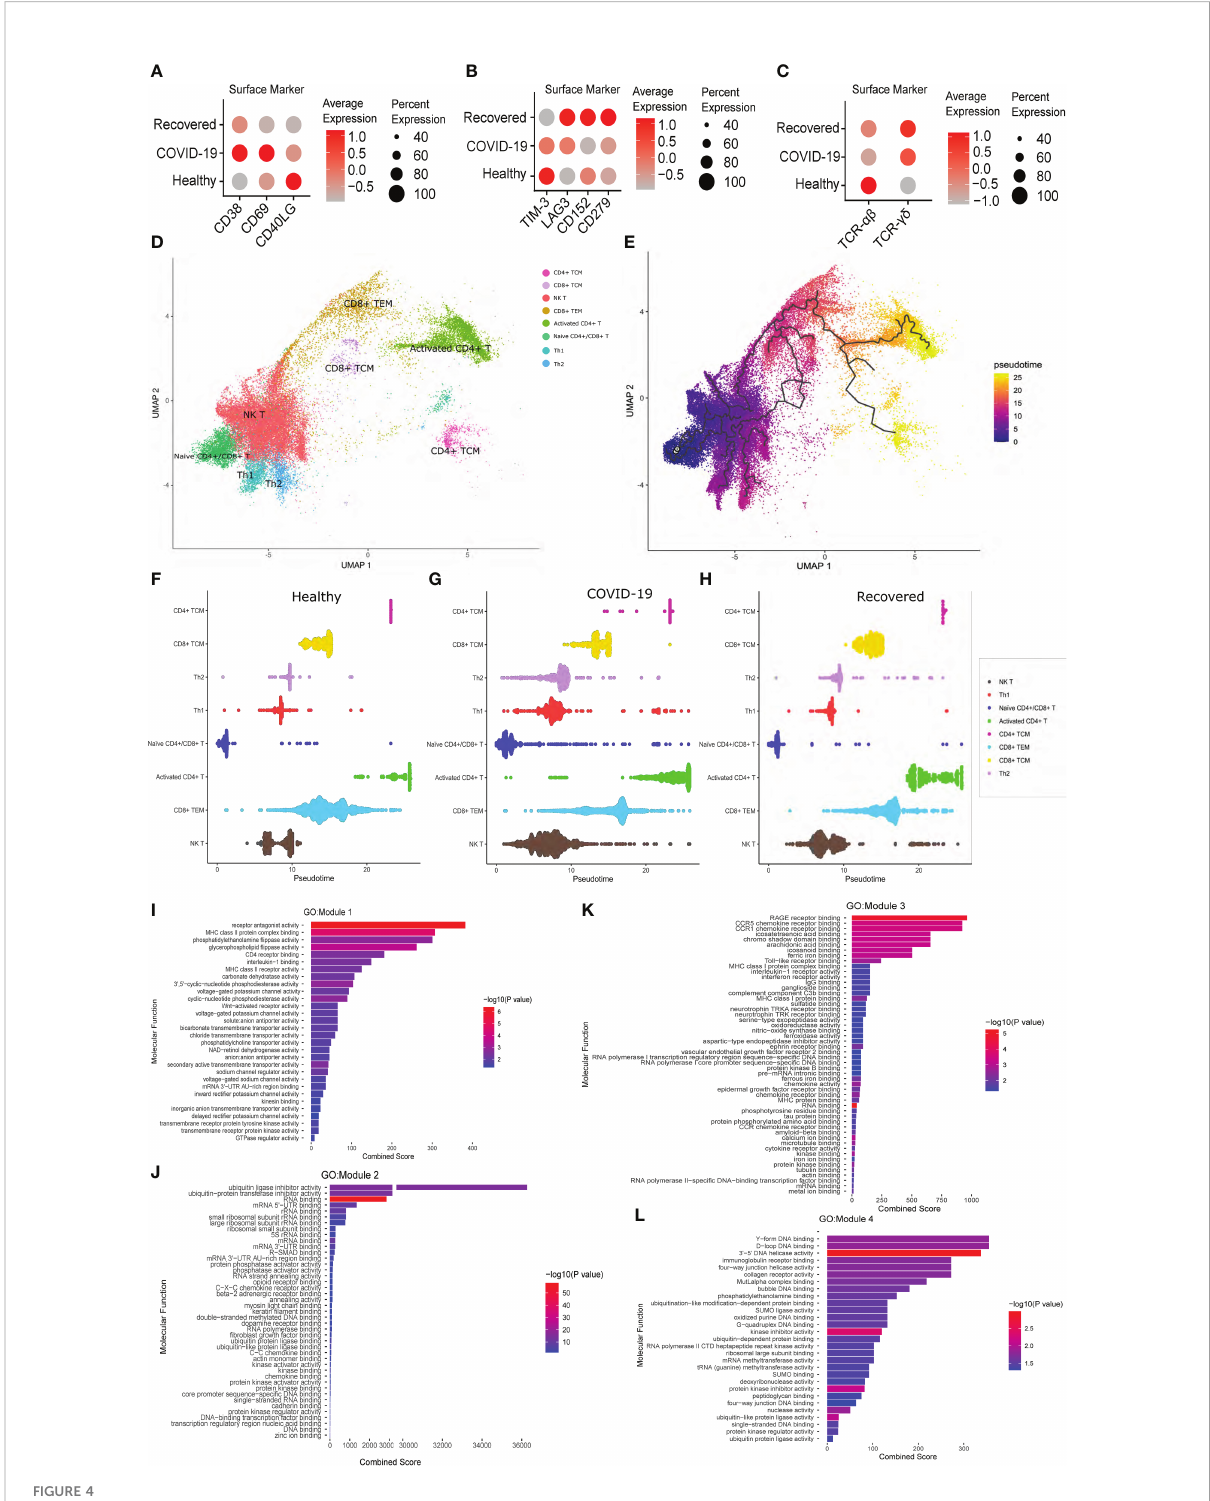
FIGURE 4 T Cell speci fi c surface marker expression and Pseudotime analysis across the healthy, COVID-19 positive and recovered individuals. (A) Expression of the T cell activation markers at the surface marker level. (B) Expression of T cell exhaustion markers at the surface marker level. (C) Expression of TCR ab and gd chain at the surface marker level. Color scale denotes the relative expression whereas circle size denotes the percentage of cells expressing the marker. (D) UMAP visualization of T cell subtypes. (E) UMAP visualization of T cell subtypes with respect to pseudotime. (F – H) Distribution of cells against pseudotime for T cell subtypes across (F) healthy, (G) COVID-19 positive, and (H) recovered individuals. (I – L) GO enrichment of genes from (I) Module 1, (J) Module 2, (K) Module 3, and (L) Module